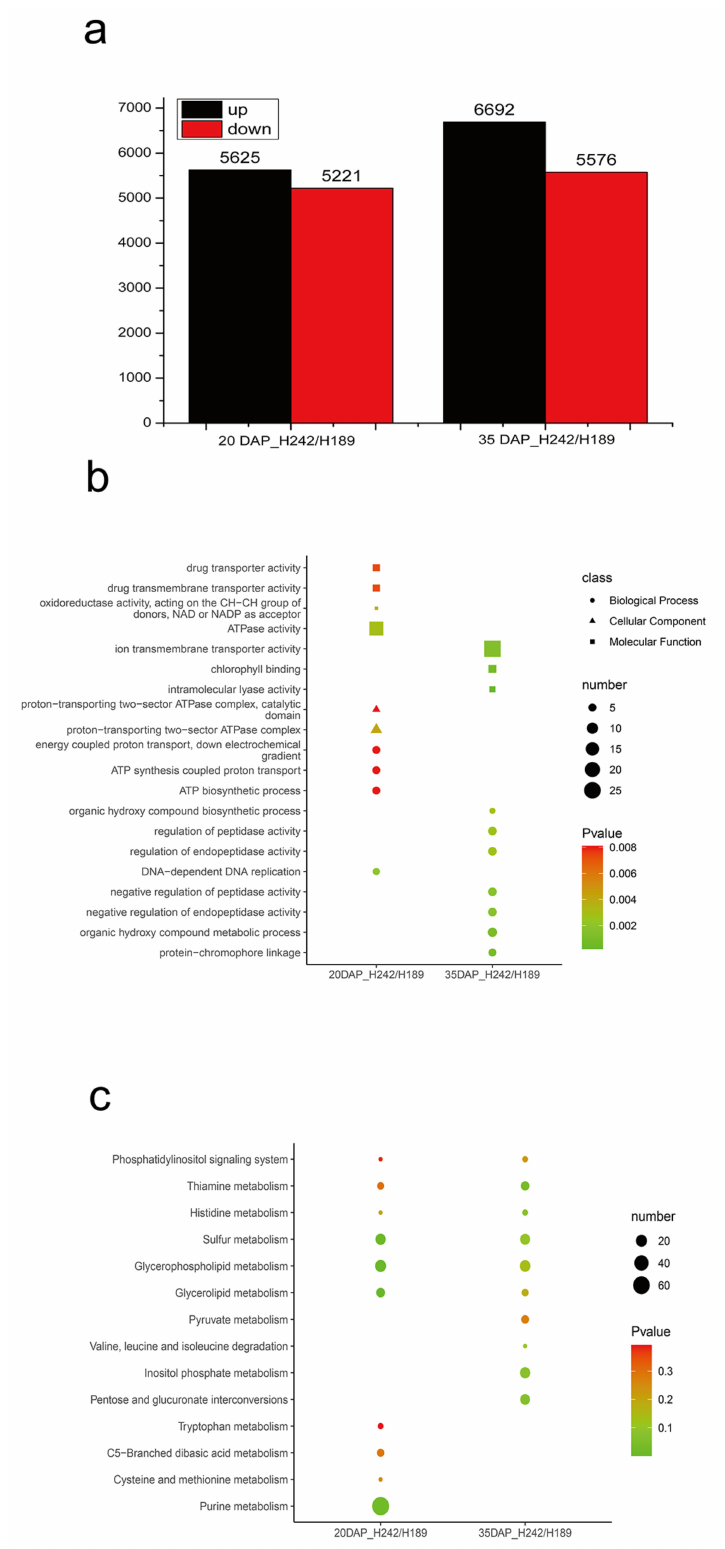
Figure 2. Gene expression profiling at 20 and 35 DAP. ( a ) Differentially expressed genes (DEGs) at 20 and 35 DAP. ( b ) GO functional classification of the DEGs at 20 and 35 DAP regarding biological processes, cellular components and molecular functions. ( c ) Enriched KEGG pathways of DEGs at 20 and 35